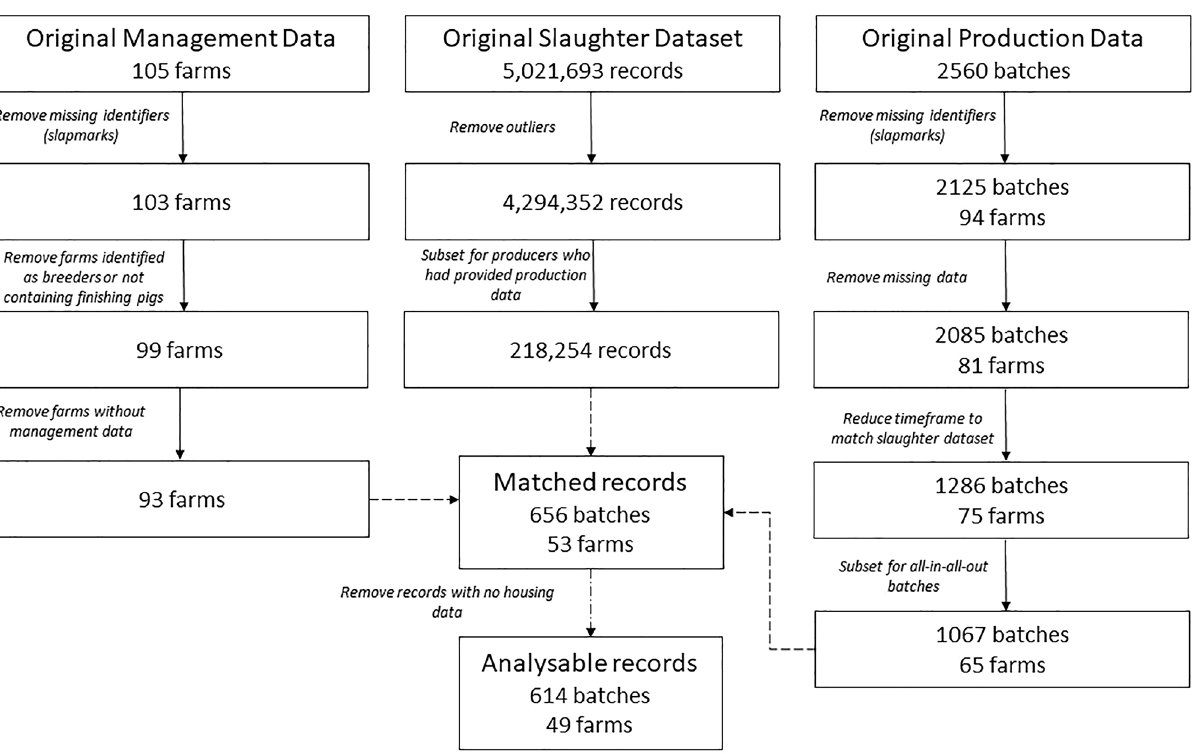
Figure 2. Data cleaning process showing how farm characteristics data, slaughter data, and production data were filtered and depicting the resulting inclusions at each stage (solid arrows). Matching between the three datasets is denoted by the dashed arrows.